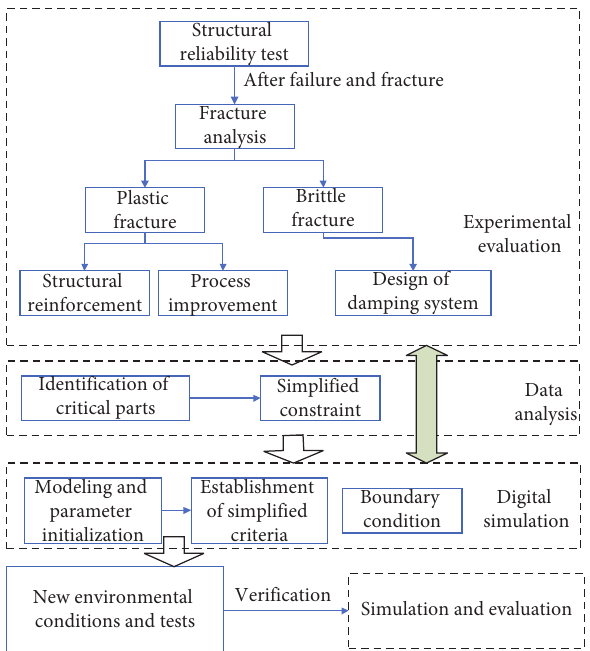
Figure 6: Flow chart of the simulation evaluation system based on the high-confidence model.